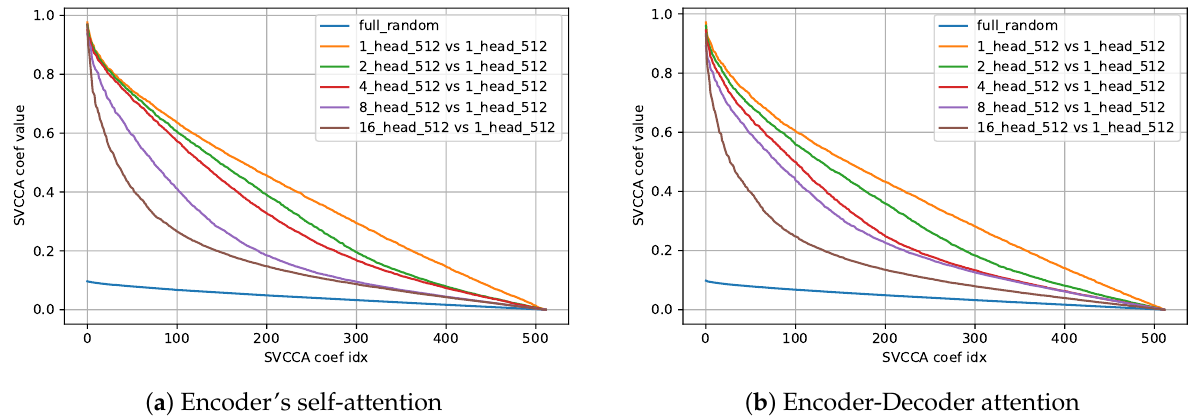
Figure 2. Singular Vector Canonical Correlation Analysis (SVCCA) coefficient curves versus a single headed